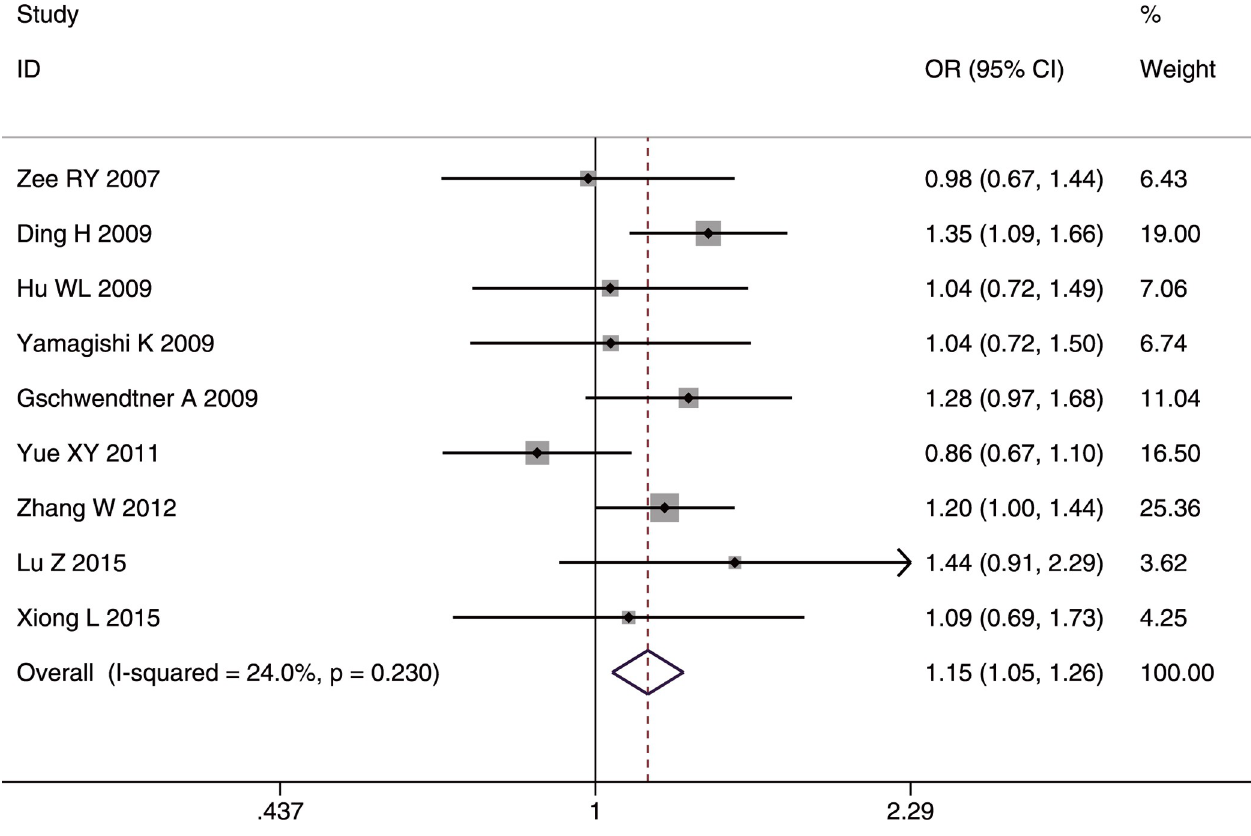
Fig 7. Forest plot of rs2383206 genotype frequency (GG vs. (AA+AG)) in the whole studied population.